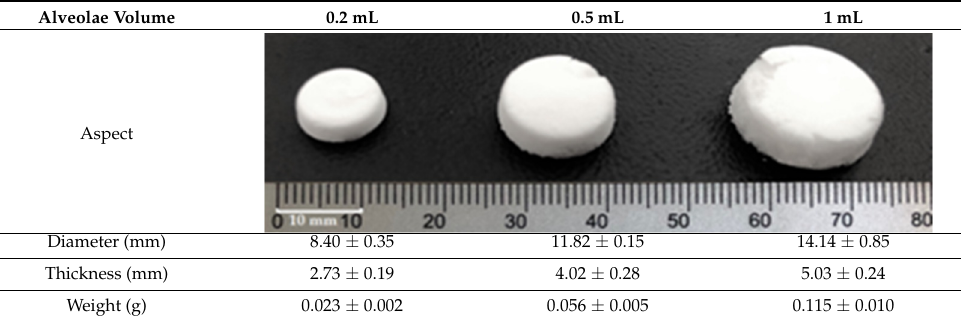
Table 3. Appearance, weight, and sizes of OLs obtained in different alveolae. Alveolae Volume